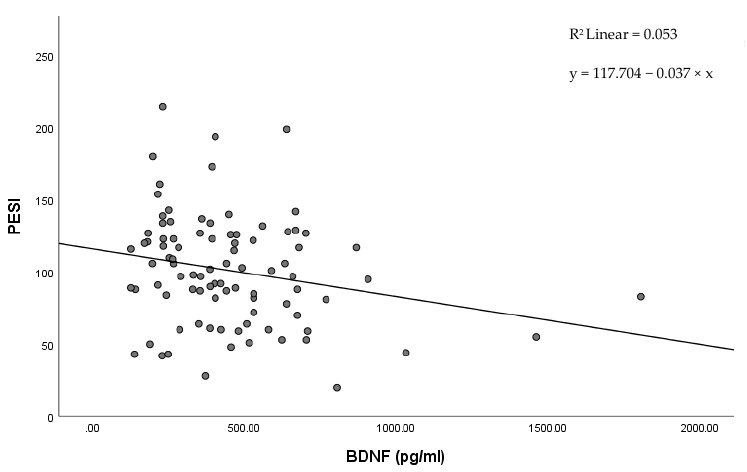
Figure 2. Scatter plot showing the correlation between BDNF and PESI score.